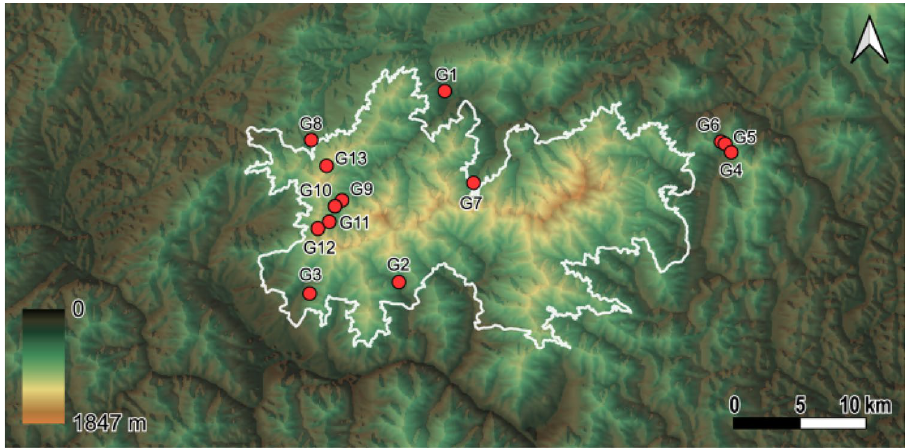
Figure 6. Thirteen yellow-legged hornet ( Vespa velutina nigrithorax ) sampling sites in Mt. Jiri National Park, South Korea. White line represents the boundary of Mt. Jiri National Park. The colors on the map represent elevation.